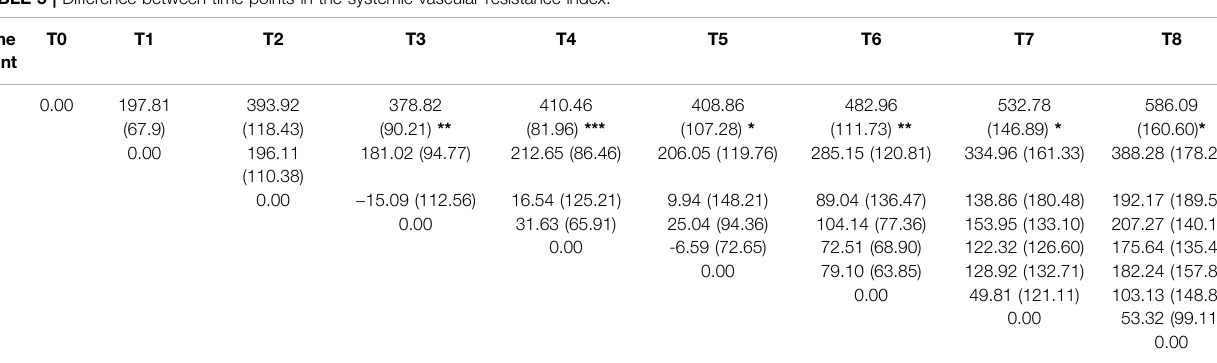
TABLE 5 | Difference between time points in the systemic vascular resistance